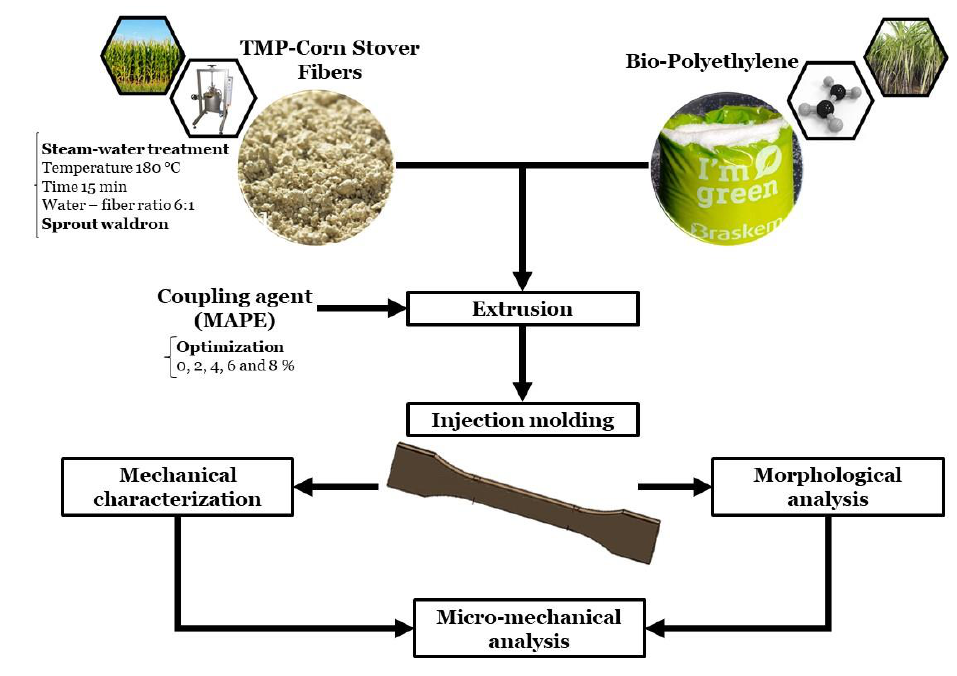
Figure 1. Chart flow of the present study.